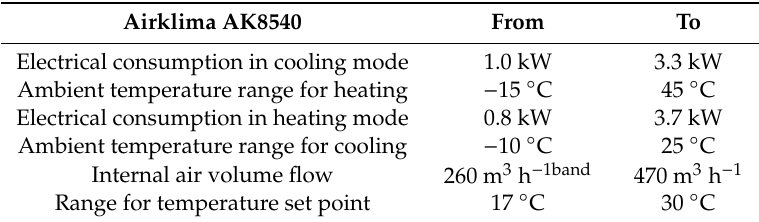
Table 2. Specification of the split air-conditioning unit of the TC.